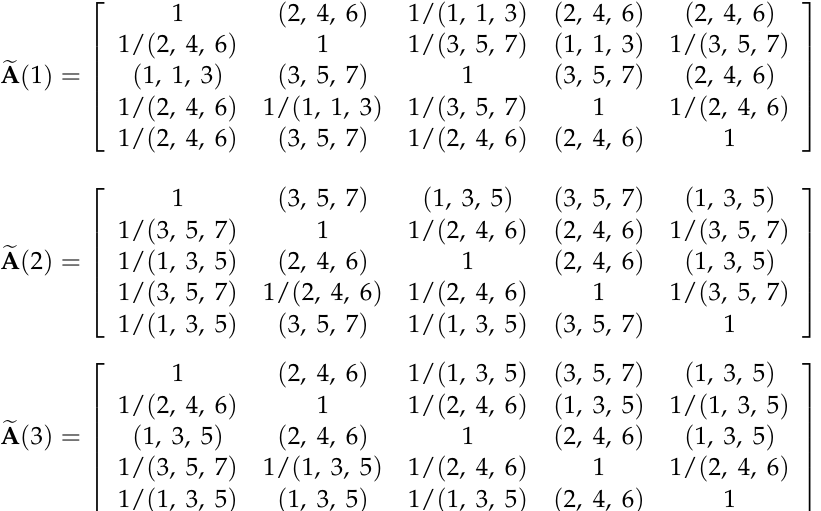
The fuzzy priorities of criteria were derived from the fuzzy judgment matrixes using the acFGM method. The results are summarized in Table 1. The fuzzy priorities of criteria are compared in Figure 5. The fuzzy consistency ratios of these fuzzy judgment matrixes were all less than 0.1, showing that they were consistent. Table 1. Fuzzy priorities of criteria derived by all decision makers.